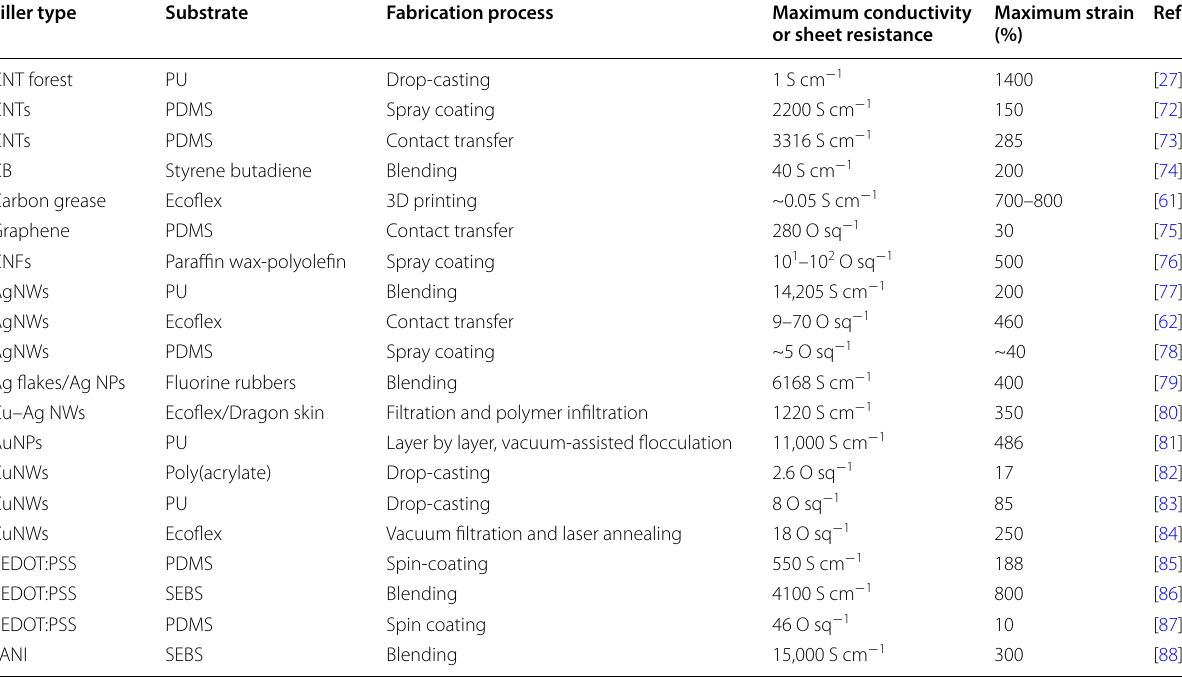
Table 2 Summary of the performance of the stretchable conductor Filler